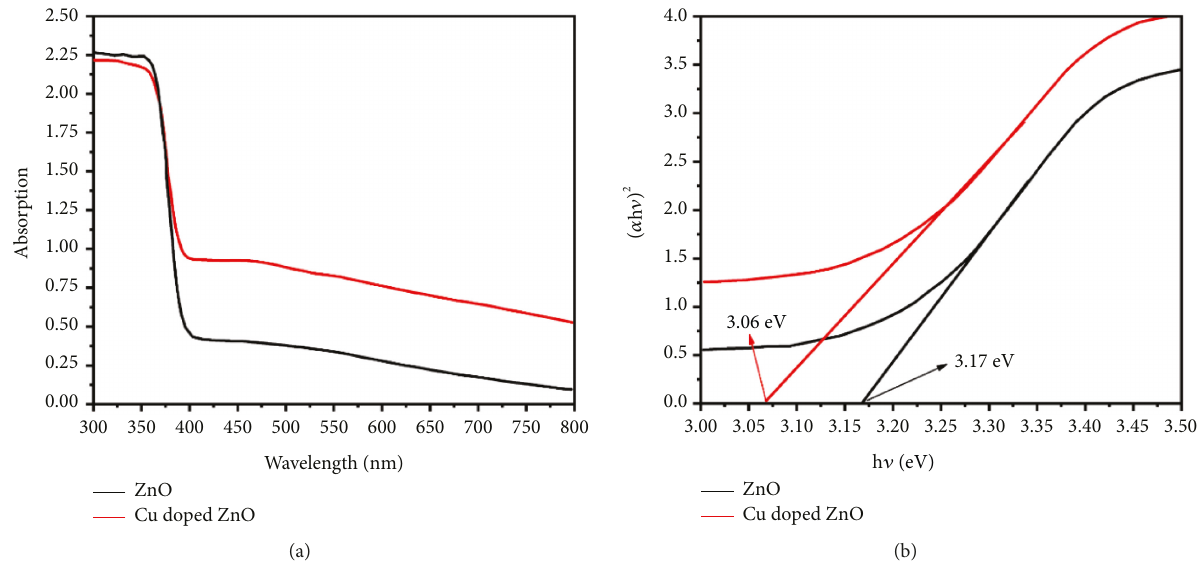
Figure 7: (a) UV-Vis absorption spectrum in the 300–700 nm range for synthesized samples of pure and Cu-doped ZnO NPs. (b) The band gap of the as-obtained ZnO and Cu-doped ZnO.